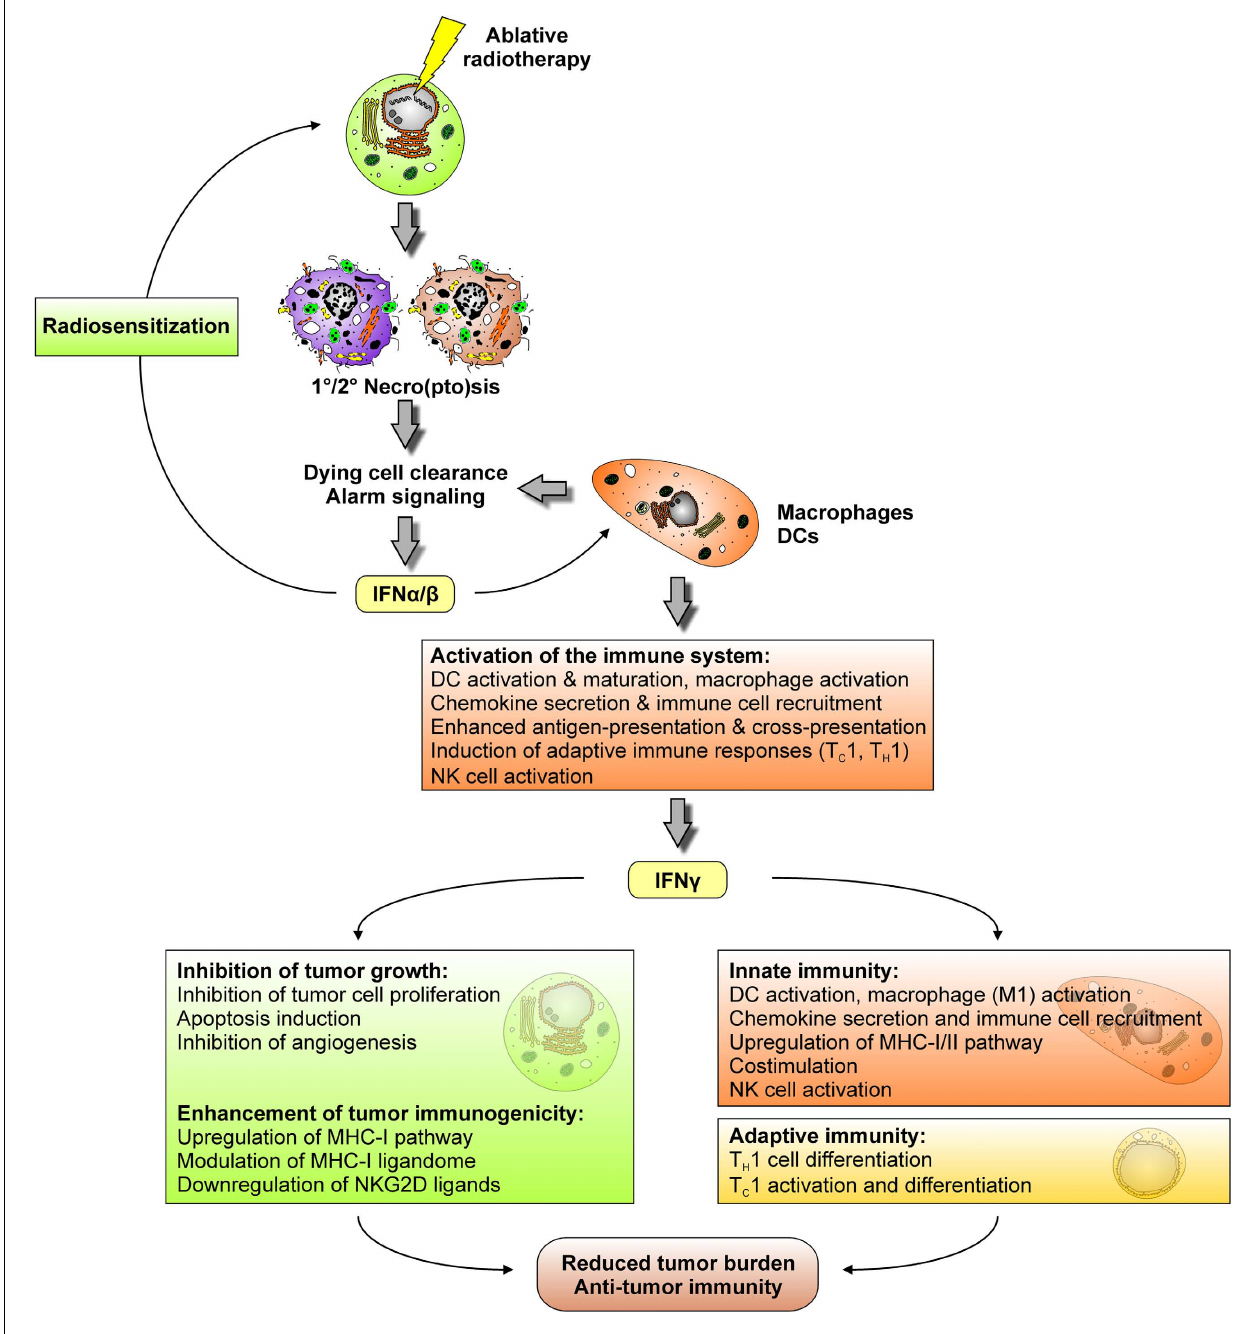
FIGURE 5 |Ablative radiotherapy stimulates a cascade of interferons, which contributes to a reduction in tumor burden and the induction of anti-tumor immunity.